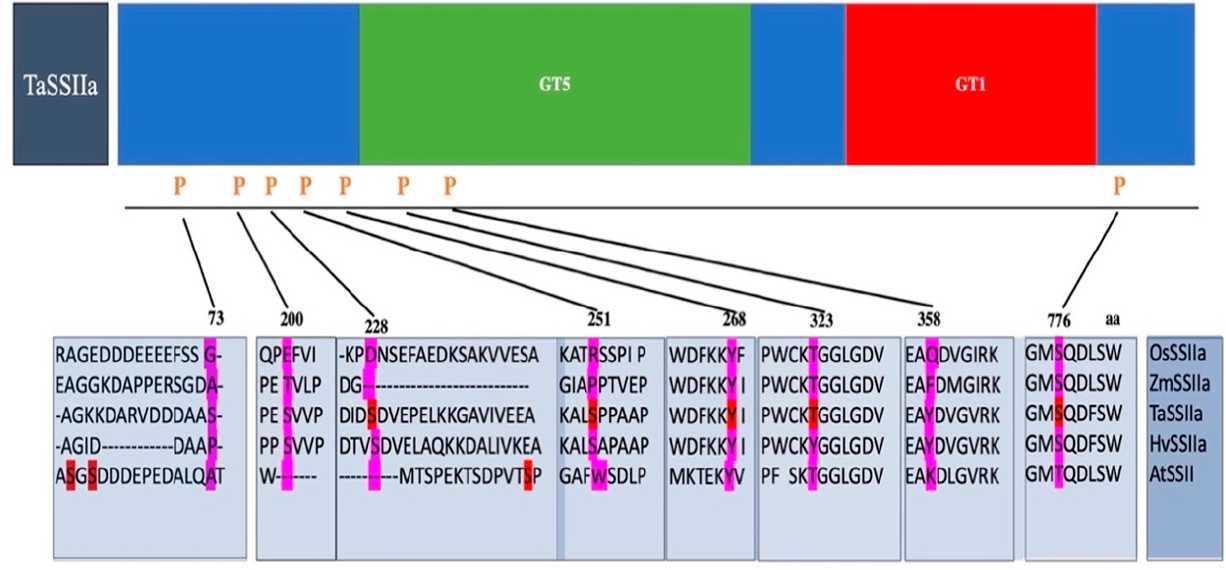
Figure 5. Alignment of SSIIa corresponding regions with different cereal crops and a description of phosphorylation sites of TaSSIIa. Phosphorylation sites are indicated in magenta and red colors were experimentally verified by Chen et al. [37] for wheat SSIIa. GT1: glycosyltransferase family 1; GT5: glycosyltransferase family 5; TaSSIIa: Triticum aestivum starch synthase IIa.